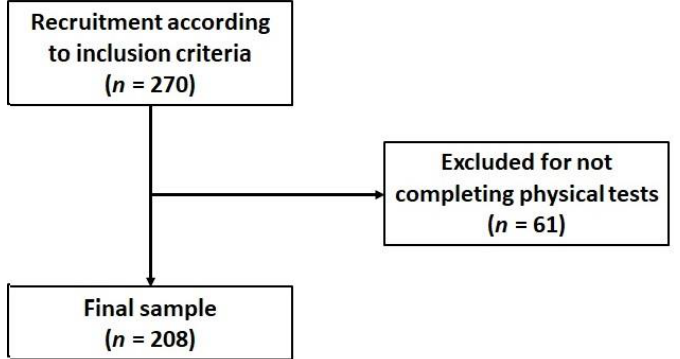
Figure 1 . Study flowchart. Figure 1. Study